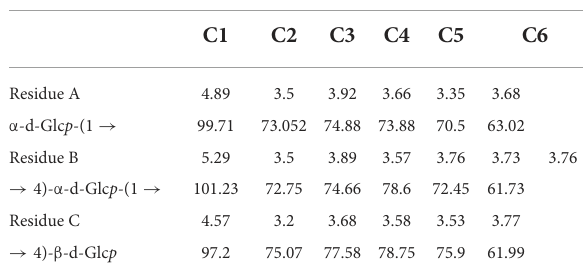
TABLE 4 1 H and 13 C nuclear magnetic resonance (NMR) chemical shifts in CAG-1